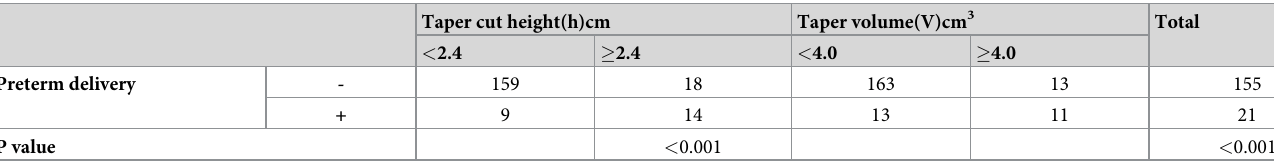
Table 7. Predictions for preterm delivery by cone height and volume.